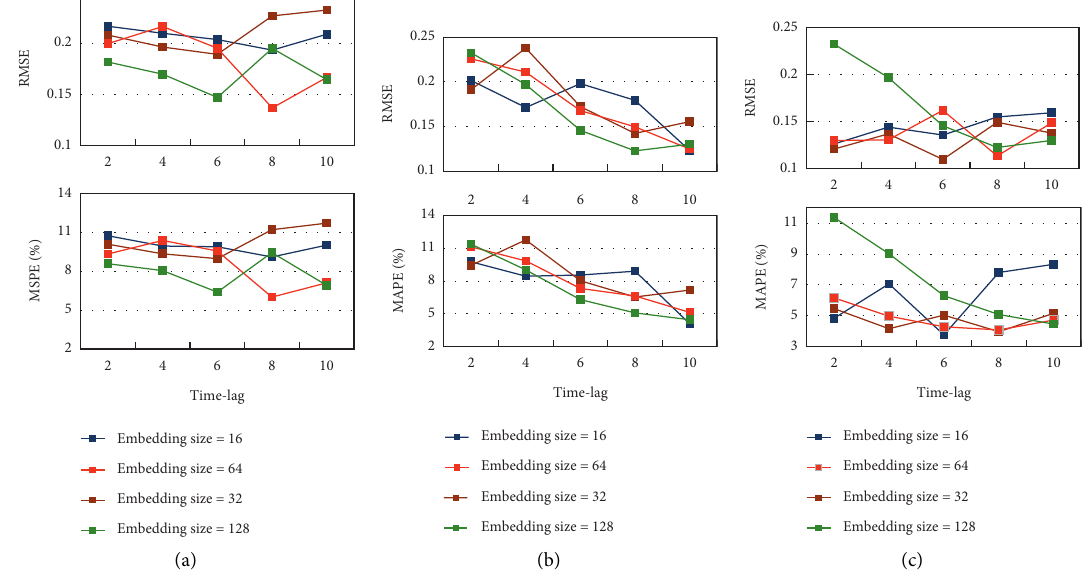
Figure 5: Key parameter sensitivity analysis for LSTM-GBRT under three time scales: (a) daily, (b) weekly, and (c) monthly CBCFI forecasting.